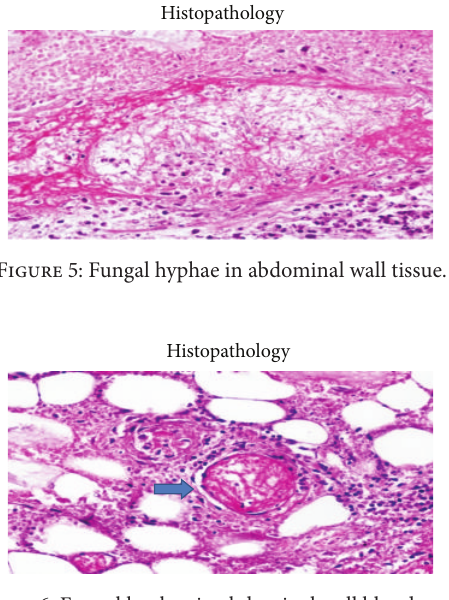
Figure 6: Fungal hyphae in abdominal wall blood